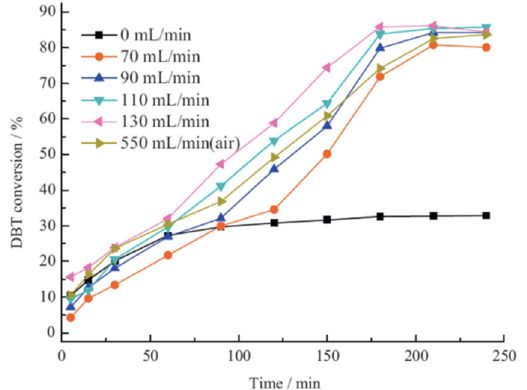
Figure 7. Effect of air and O 2 flow rate on DBT removal rate with HPW@MOFs. Conditions: reaction temperature, 90 °C; catalyst dosage, 1% the mass of normal octane; extracting agent, distilled water; reaction time, 240 min [79].